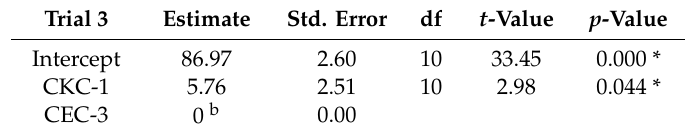
Table 16. The significant di ff erence of mean scores obtained in Trial 3 between CKC-1 and CEC-3. Trial 3 Estimate Std. Error df t -Value p -Value Intercept 86.97